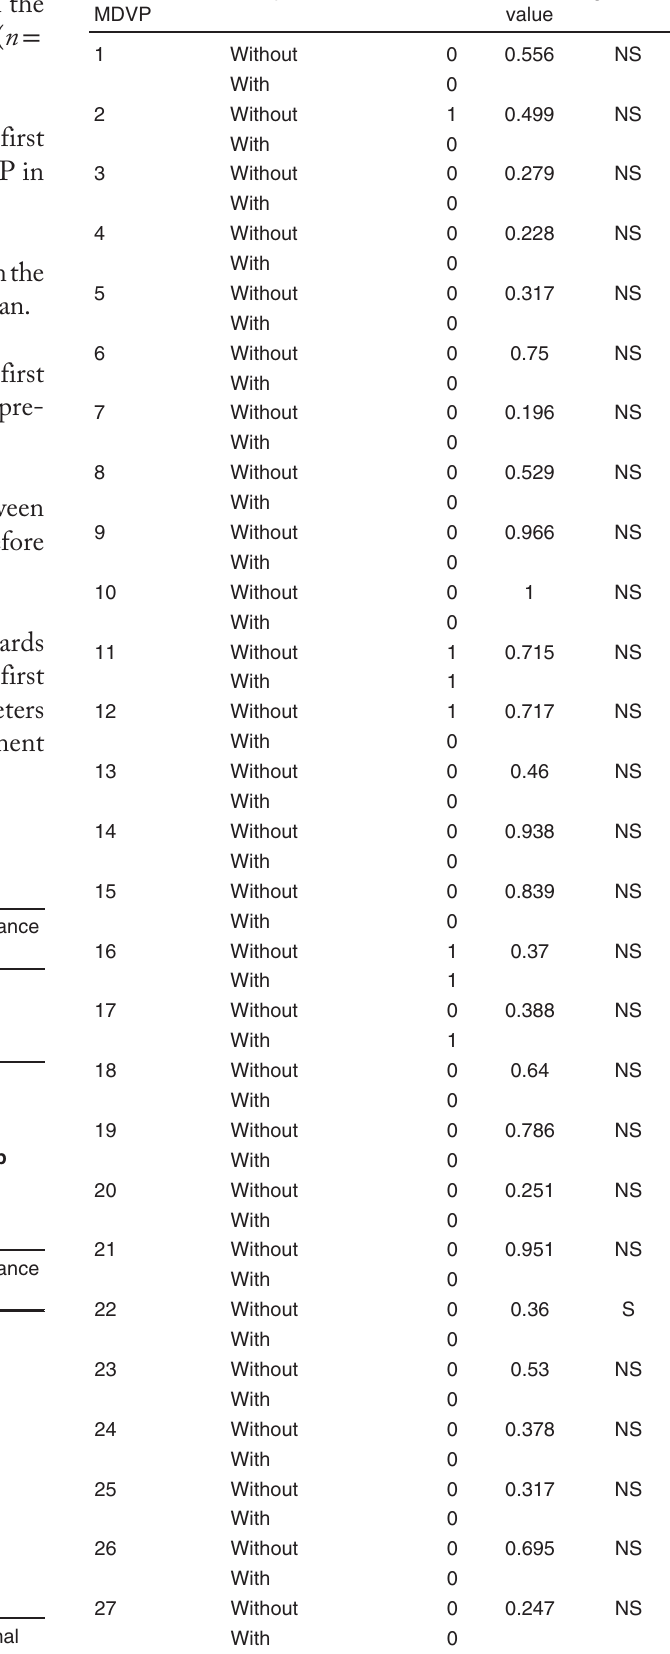
Table 3 Comparison between the results of the first group that received voice hygiene advices and the control group according to the VHI questions in pre-Ramadan